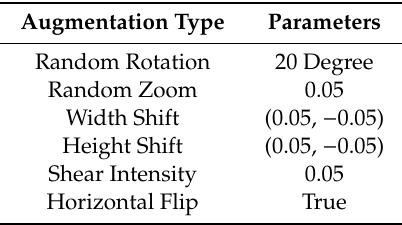
Table 1. Augmentation